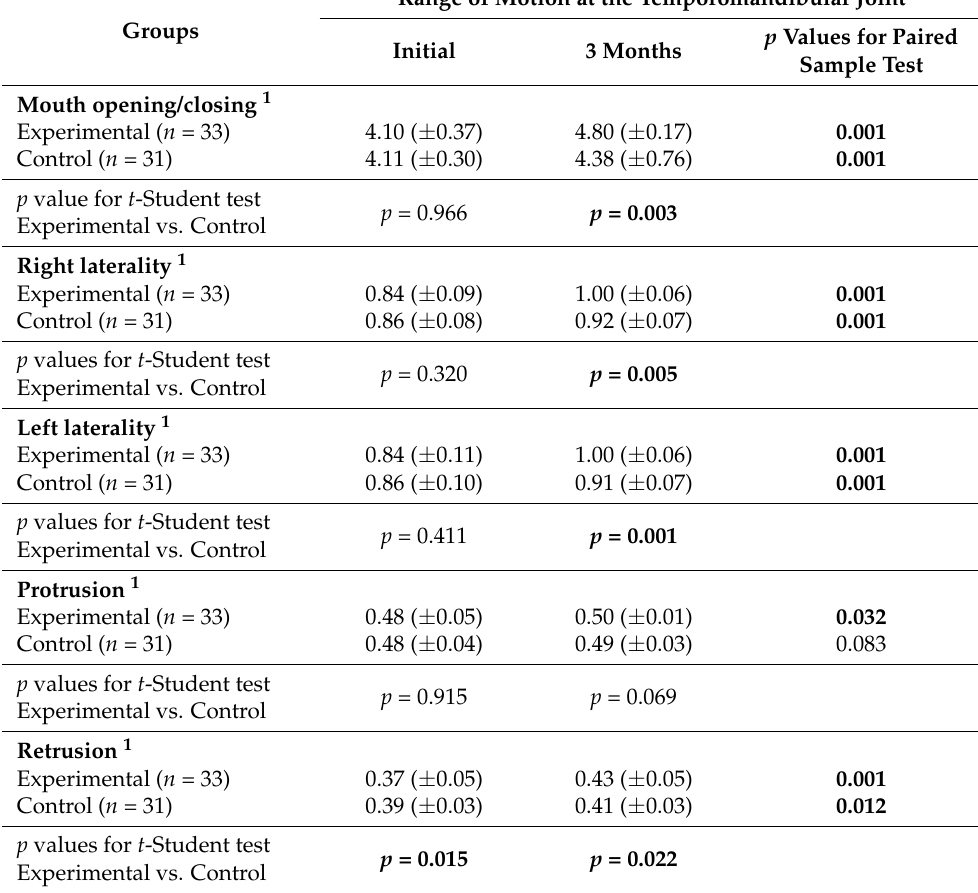
Table 6. Temporomandibular joint testing.